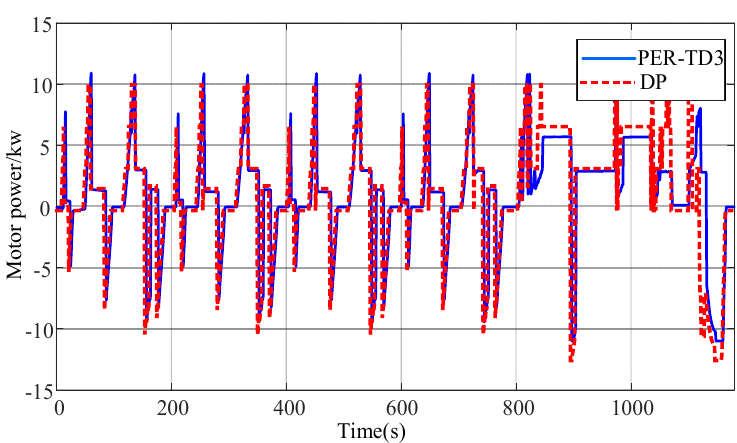
Figure 12 . Motor power distribution of PER ‐ TD3 and DP.